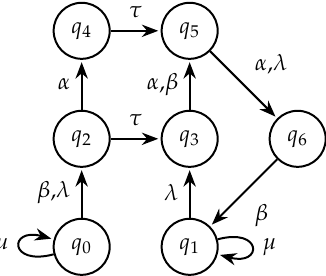
Figure 8. The skeleton of a supervisor for G (cid:48)(cid:48) ( q 0 ) and G (cid:48)(cid:48) ( q 1 )